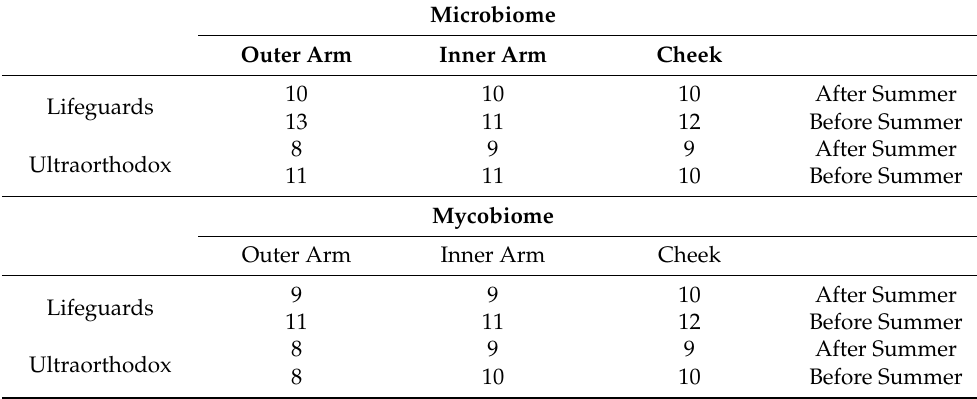
Table 1. Summary of the samples